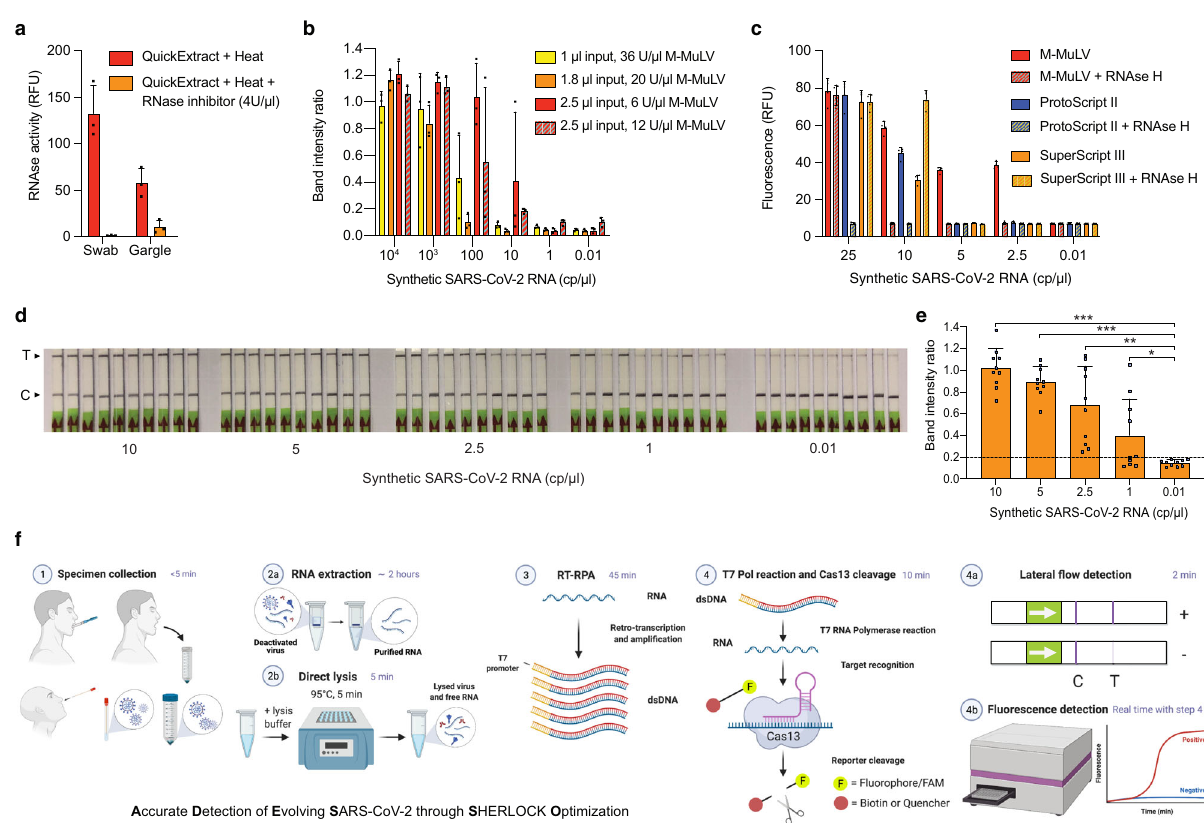
Fig. 1 ADESSO: an optimized and highly sensitive SHERLOCK-based assay for SARS-CoV-2 detection. a Measurement of RNase activity in a swab and gargle sample lysed at 95 °C for 5 minutes with QuickExtract DNA Extraction Solution enriched or not with Murine RNase inhibitor, at a fi nal concentration of 4 U/ μ l. b Determination of sensitivity on serial dilutions of SARS-CoV-2 synthetic genome upon optimization of RT units and input volume in the RT- RPA reaction with lateral fl ow readout. c Sensitivity on serial dilutions of SARS-CoV-2 genome using different reverse transcriptases in presence or absence of RNase H. d Sensitivity of the improved protocol with lateral fl ow readout on serial dilutions of SARS-CoV-2 synthetic genome upon integration of all the above-described optimizations. e Intensity ratios of the lateral fl ow strips in d are shown in a bar plot. An unpaired, two-tailed t-test was performed (* P = 0.0302; ** P = 0.0002; *** P < 0.0001). f Graphic of the experimental work fl ow of ADESSO to detect SARS-CoV-2, with or without RNA extraction, in clinical samples with lateral fl ow or fl uorescence readout. For panels d , f : T = test band; C = control band. For panels a , b , c , e : bars represent the mean for n replicates and error bars represent the positive standard deviation. For a , b : n = 3 biological replicates; for c : n = 4 technical replicates; for e : n = 10 biological